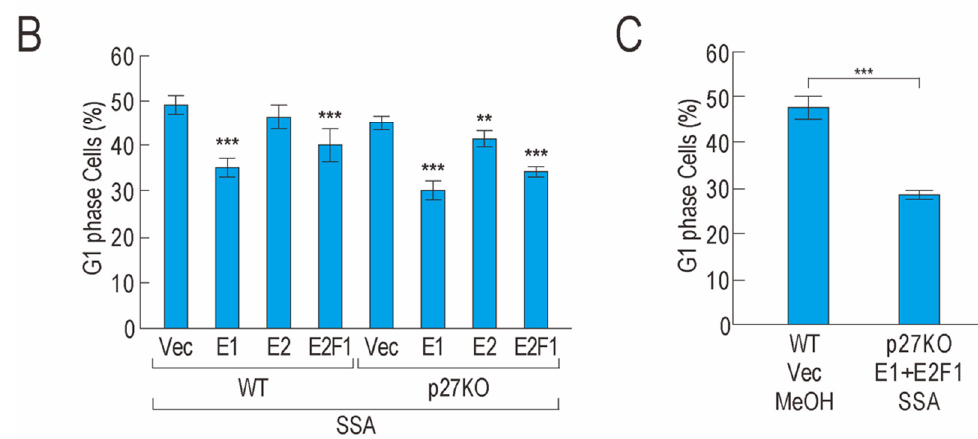
Figure 3. Overexpression of CCNE1 and E2F1 partially suppresses cell cycle arrest. ( A , B ) HeLa wild-type (WT) or p27 KO cells were transfected with pcDNA3.1-Myc/HIS (Vec), CCNE1 -Myc (E1), CCNE2 -Myc (E2), or E2F1 -Myc (E2F1). The transfected cells were then treated with 10 ng/mL SSA or MeOH for 24 h. The proteins were analyzed using immunoblotting ( A ), and the cell cycle was analyzed using a cytometer ( B ). ( C ) HeLa WT cells or p27 KO cells were transfected with pcDNA3.1- Myc/HIS (Vec) or CCNE1 -Myc (E1) and E2F1 -Myc (E2F1). The transfected cells were treated with 10 ng/mL SSA or MeOH for 24 h. The cell cycle was analyzed using a cytometer. Error bars indicate standard deviation (n = 3). Statistical significance was investigated using one-way ANOVA and Dunnett’s test (B) or a two-tailed t -test (C) (** p < 0.01; *** p < 0.001).